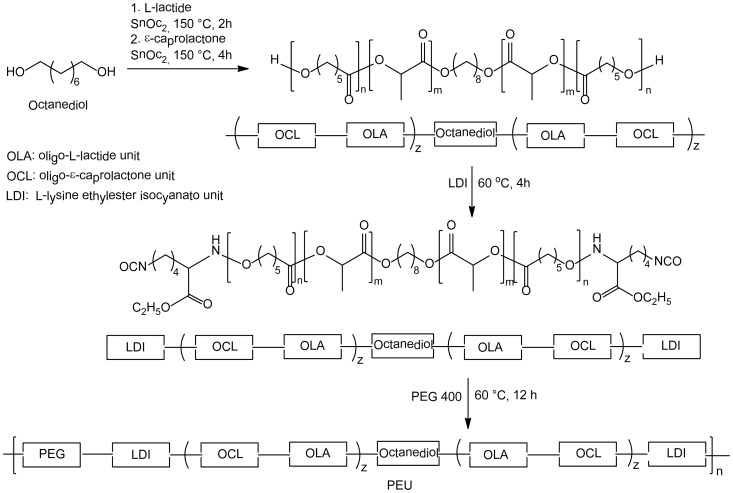
Schematic composition of copolymer PEU.